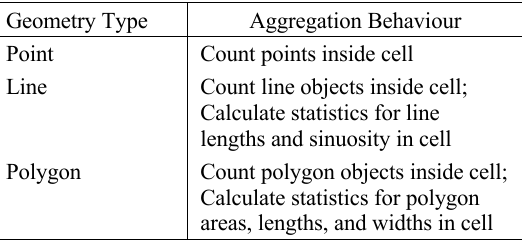
Table 1 . Geo-binning behaviour for geometry types.